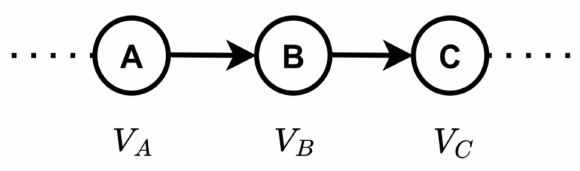
Figure 2. Single-chain subgraph.